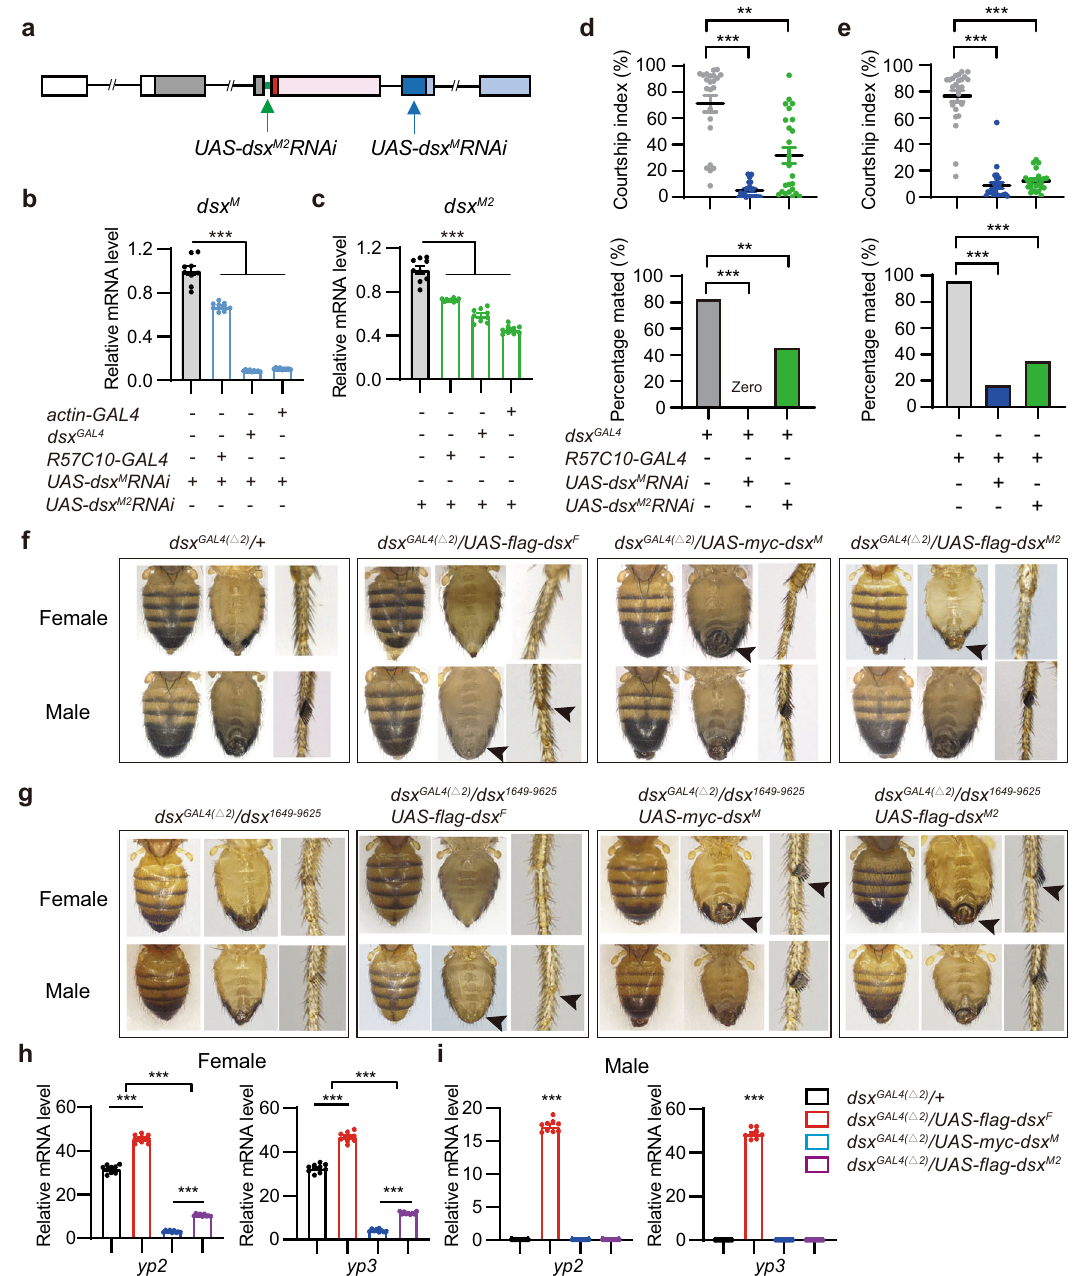
Fig. 2 dsx M2 has a potentially masculinizing function like dsx M . a RNAi targeting dsx M and dsx M2 as indicated by blue and green arrows, respectively. b , c Relative mRNA expression levels of dsx M ( b ) and dsx M2 ( c ) in control and RNAi-mediated males. n = 9 based on three replicates for each. *** p < 0.001, Mann-Whitney U test. d , e Knocking down dsx M or dsx M2 in dsx -expressing cells ( d ) or pan-neuronally ( e ) impairs male courtship and mating success with females. n = 23, 24, 24, 24, 24, 24 for dsx GAL4 / + , dsx GAL4 /UAS-dsx M RNAi, dsx GAL4 /UAS-dsx M2 RNAi, R57C10-GAL4/ + , R57C10-GAL4/UAS-dsx M RNAi and R57C10-GAL4/UAS-dsx M2 RNAi respectively. For courtship index, ** p = 0.0012 and *** p < 0.001, Kruskal-Wallis test with Dunn ’ s multiple comparisons test; for percentage mated, ** p = 0.0087 and *** p < 0.001, Chi-square test. f , g Overexpression of Dsx F feminized, while overexpression of Dsx M or Dsx M2 masculinized dsx -expressing cells, including external genitalia and sex comb (arrowhead), under wild-type background [ f , dsx GAL4( Δ 2) / + ] or mutant background [ g , dsx GAL4( Δ 2) /dsx 1649-9625 ] for dsx . h , i Relative mRNA expression levels of dsx target genes, yp2 and yp3 , in females ( h ) and males ( i ). Expression levels of yp2 and yp3 were increased with Dsx F overexpression and decreased with Dsx M or Dsx M2 overexpression. n = 9 based on three replicates for each. *** p < 0.001. Mann-Whitney U test. Error bars indicate